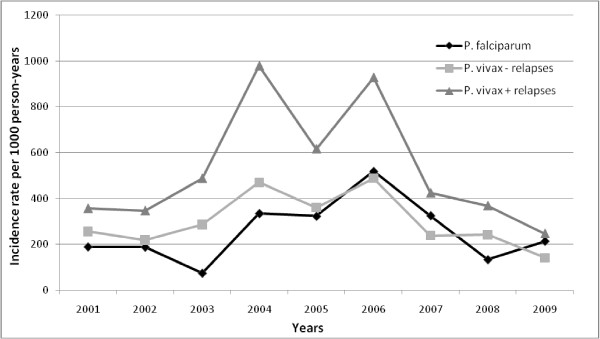
Inter-annual variations of malaria incidence rates per 1000 person-years attributed to P. falciparum and P. vivax (including and excluding relapses). Incidence rates were calculated for the population 0 - 7 years old.